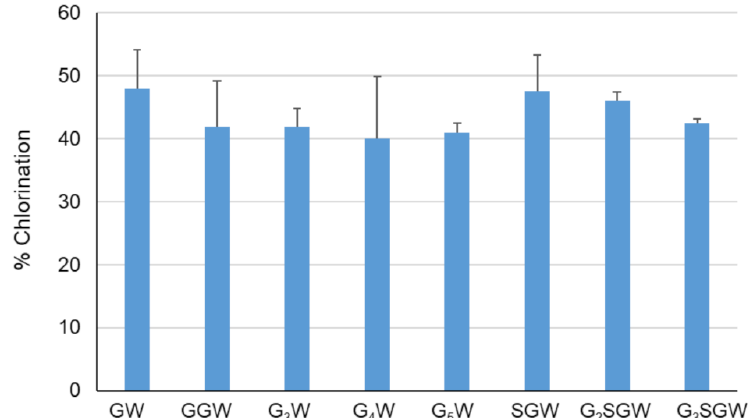
Figure 2. Screen for ( A ) chlorination and ( B ) bromination of indicated tripeptides using ThHal (blue), SttH (orange) and PyrH (grey) enzymes.